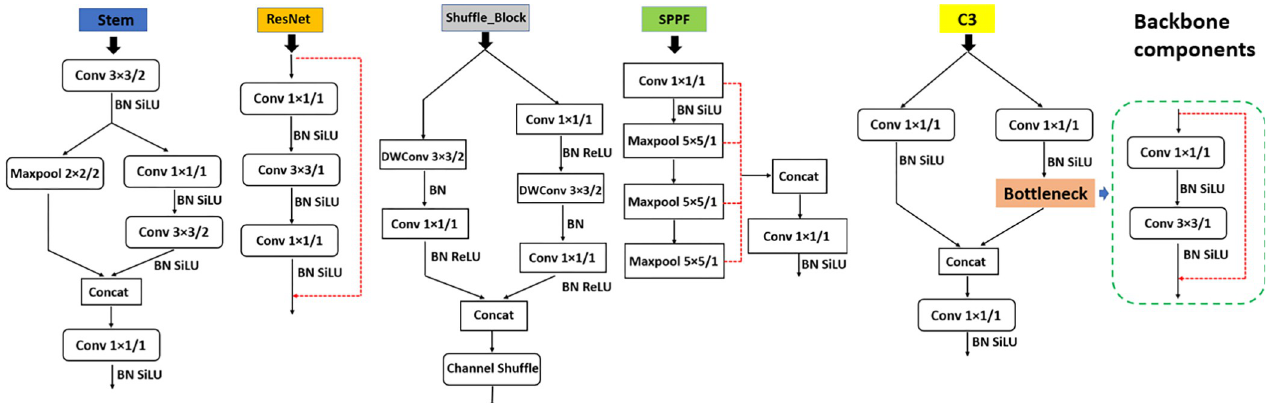
Fig 2. Backbone component of YOLOv5-LiNet. Stem, ResNet, Shuffle_Block, SPPF and C3 incorporated into neck network.